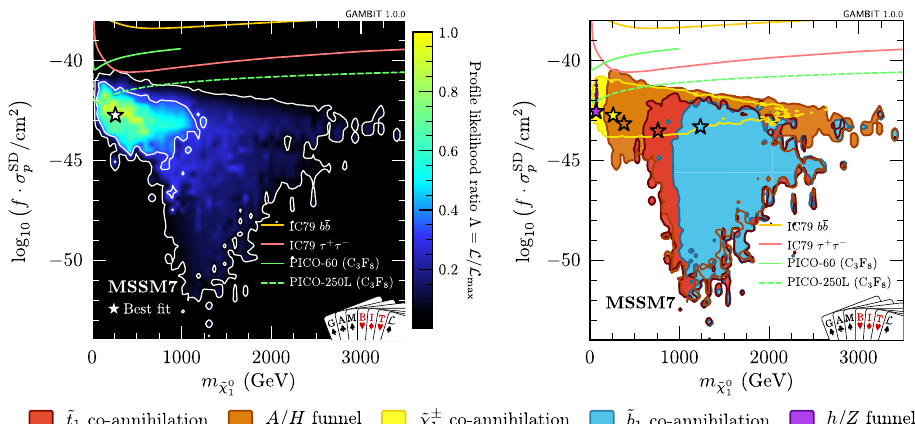
Fig. 13 Spin-dependent neutralino-proton scattering cross-sections in the MSSM7, rescaled by the fraction f of the observed relic density predicted by each model. Left: profile likelihood, showing 68 and 95% CL contours. Right: mechanism(s) that allow models within the 95% CL region of the profile likelihood to avoid exceeding the observed